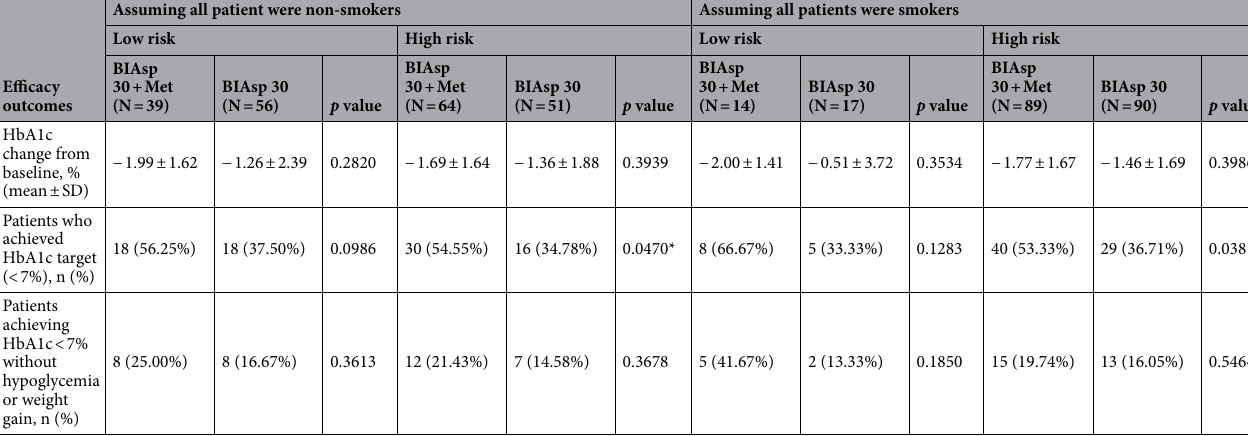
the BIAsp 30 monotherapy group included 56 low-risk patients and 51 high-risk patients. Assuming all patients were smokers, the BIAsp 30 plus metformin group included 14 low-risk patients and 89 high-risk patients, while the BIAsp monotherapy group included 17 low-risk patients and 90 high-risk patients (Table 1). Regardless of whether we assumed all patients were non-smokers or smokers, the 2 treatments led to compa- rable HbA1c changes from baseline and comparable percentages of patients achieving the composite endpoint of HbA1c < 7% without hypoglycemia or weight gain in both low-risk patients and high-risk patients (All P > 0.05) (Table 1). Meanwhile, regardless of whether we assumed all patients were non-smokers or smokers, BIAsp 30 plus all were non-smokers and smokers, respectively), while comparable percentages of low-risk patients in the 2 treatment groups achieved HbA1c target of < 7% ( P > 0.05) (Table 1). BIAsp 30 plus metformin and BIAsp 30 monotherapy had overall comparable safety profiles for both low‑risk and high‑risk patients. Safety analyses were performed on the SS which included 128 and 125 patients in the BIAsp 30 plus metformin and the BIAsp monotherapy groups, respectively. Among them, records of 101 and 106 patients in the BIAsp 30 plus metformin group and the BIAsp 30 monotherapy group were complete for the purpose of GloboRisk calculation, respectively. Assuming all patients were non-smokers, the BIAsp 30 plus metformin group included 38 low-risk patients and 63 high-risk patients, while the BIAsp 30 monotherapy group included 55 low-risk patients and 51 high-risk patients. Assuming all patients were smokers, the BIAsp 30 plus metformin group included 14 low-risk patients and 87 high-risk patients, while the BIAsp monotherapy group included 16 low-risk patients and 90 high-risk patients (Table 2). Regardless of whether all patients were assumed non-smokers or smokers, the 2 treatment groups had com- parable percentages of patients who had AE(s) and patients experiencing at least 1 hypoglycemic episode as well as comparable numbers of hypoglycemic episode per patients in both low-risk and high-risk patients ( P all > 0.05) (Table 2). Meanwhile, regardless of whether all patients were assumed non-smokers or smokers, low-risk patients in the 2 treatment groups had comparable percentages of patients experiencing treatment-related adverse reaction(s) as well as comparable weight gains from baseline (All P > 0.05) (Table 2). High-risk patients in the BIAsp 30 plus metformin group had significantly less weight gain than patients in the weight gains ( P > 0.05) (Table 2). Finally, when we assumed all patients were smokers, significantly higher percentage of high-risk patients in the BIAsp plus metformin group experienced treatment-related adverse reactions than patients in the BIAsp monotherapy group (21.84% vs 8.89%, P = 0.0166), while when all patients were assumed non-smokers, the 2